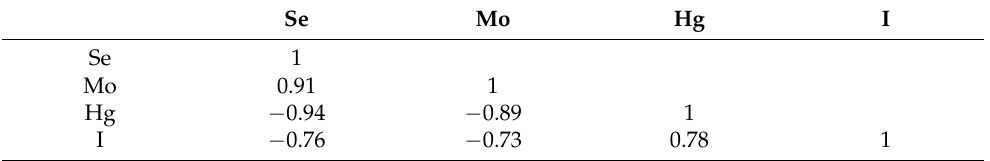
Table 4. The Pearson correlation of Se network elements (on natural log